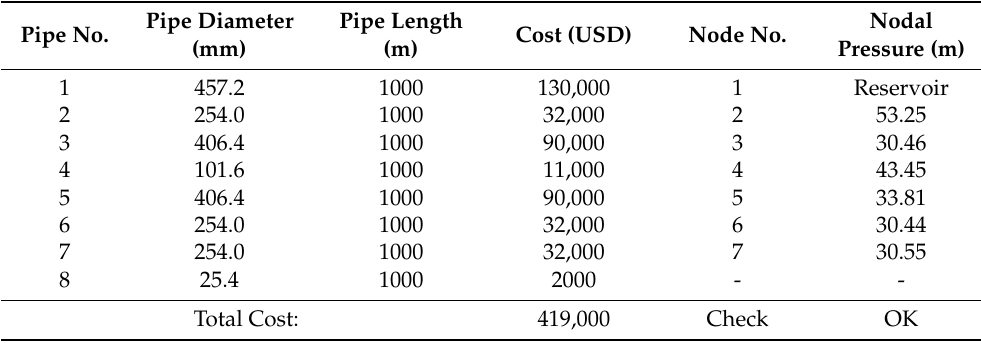
Table 5. SOP–WDN results for the Two-loop network. Pipe